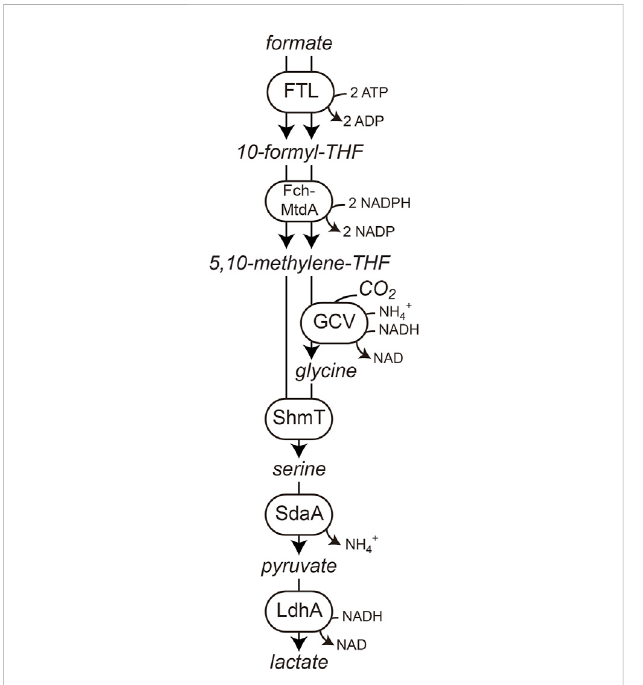
FIGURE 1 Reductive glycine pathway as operating in the formatotrophic E.coli strain.DisplayedisformateandCO 2 conversiontolactateasa fi nal